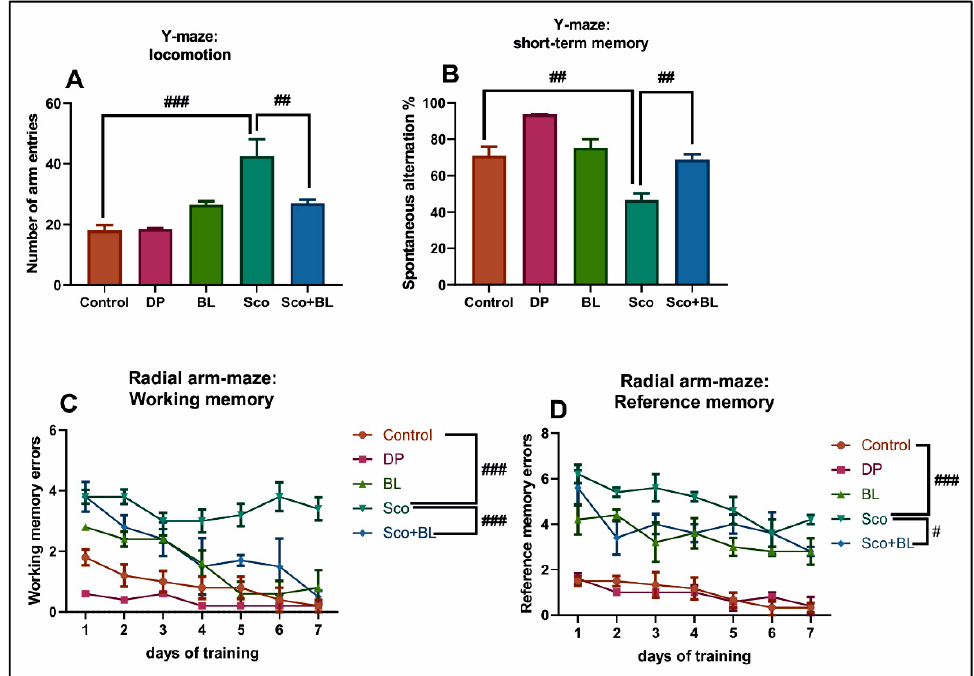
Figure 3. Behavioral analysis for the Y-maze and the radial-arm maze (RAM) tests. ( A ) represents the graph for the number of entries in the Y-maze test in different groups; ( B ) represents the graph for the spontaneous alternation percentage in the Y-maze test in different groups; ( C ) represents the graph for the working memory errors in RAM in different groups; ( D ) represents the graph for the reference memory errors in RAM in different groups. Data are expressed as means ± SEM ( n = 5 and statistical analysis by one-way ANOVA followed by Tukey’s post hoc analyses: ( A ) Control vs. Sco: ### p < 0.0001, and Sco vs. Sco + BL: ## p < 0.001; ( B ) Control vs. Sco: ## p < 0.001, and Sco vs. Sco + BL: ## p < 0.001; ( C ) Control vs. Sco: ### p < 0.0001, and Sco vs. Sco + BL: ### p < 0.0001; ( D ) Control vs. Sco: ### p < 0.0001, and Sco vs. Sco + BL: # p < 0.01.